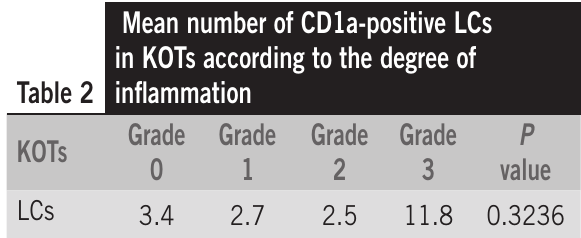
Mean number of CD1a-positive LCs in KOTs according to thickness of the cystic